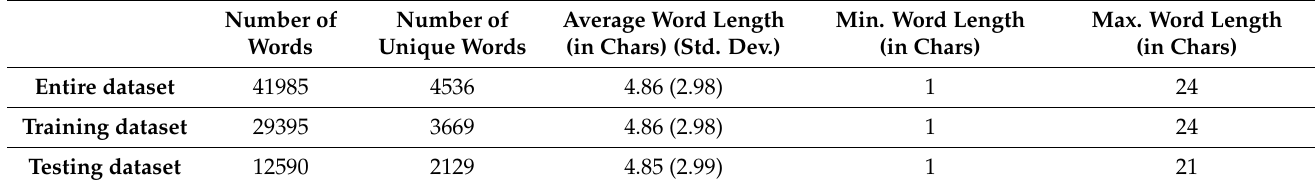
Table 2. Descriptive statistics for the words in the dataset.